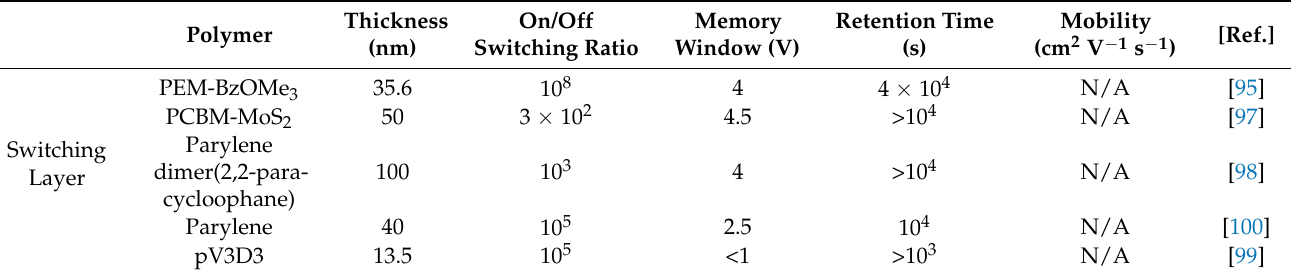
Table 4. Memristor characteristics